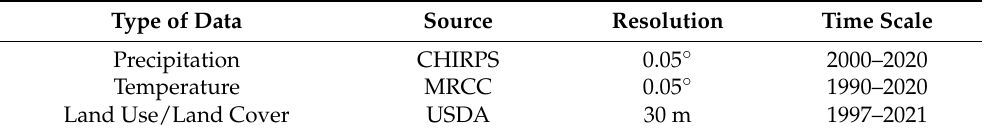
Table 1. Sources of data used in the study. Type of Data Source Resolution Time